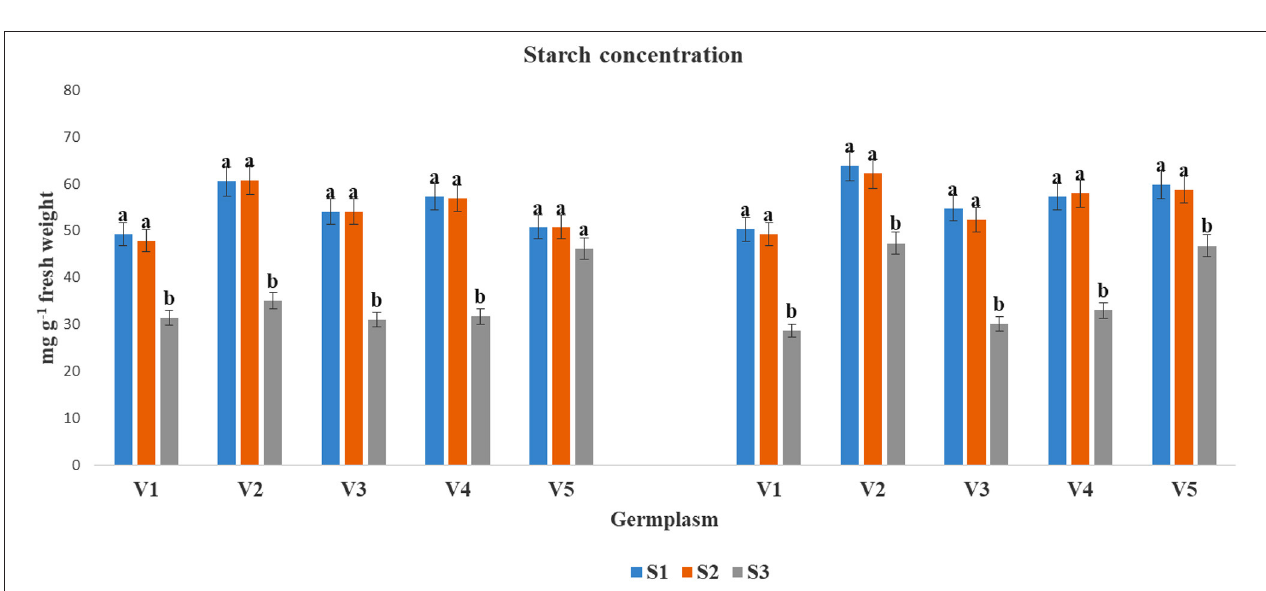
FIGURE 2 | Starch concentrations (mg g − 1 fresh weight) at mid-flowering stage in top leaf of mustard varieties sown at three different dates during rabi 2017–2018 and 2018–2019. Different date of sowing represented as S1 timely sown (30 October), S2 late sown (15 November) and S3 very late sown (30 November 30 Varieties symbolize with: V1, PM 25; V2, PM 26; V3, BPR-541-4; V4, RH-406; and V5, Urvashi, respectively. The mean value ± p ≤ 0.05 error bar data were presented in the figure and different alphabetical letters indicate the significant difference for each variety under different date of sowing ( p ≤ 0.05). considerable increased level of erucic acid content was found inV1, V2, V4, and V5, respectively specially at S1 and S2 growth stages of mustard ( Figure 5B